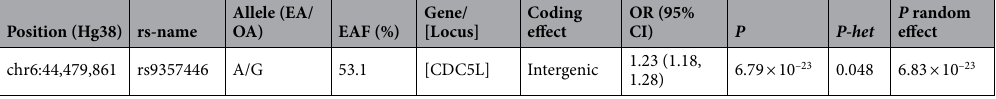
Table 1. Association of a novel, genome-wide significant variant identified in the Bell’s palsy meta-analysis. Significance levels and effects are shown for the combined analysis. EA effect allele, OA other allele, EAF effect allele frequency, OR odds ratio, CI confidence interval, P-het P -value for test of heterogeneity between Iceland, the UK, Denmark, and Finland.